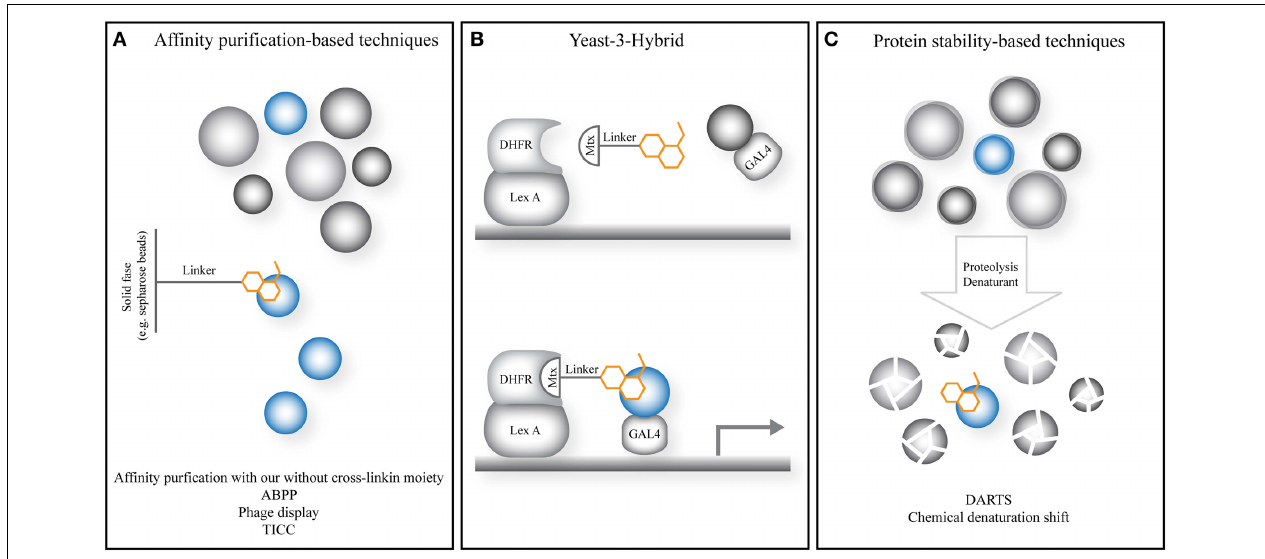
FIGURE 2 | General principle of emerging and novel target identification strategies in plant chemical biology. (A) Strategies relying on the affinity of the small molecule to isolate the target protein from a complex mixture such as a lysate or cellular environment. (B) The yeast-3-hybrid approach uses the activation of a transcriptional response by bringing together a DNA-binding domain and transcriptional activator via a fusion of the small molecule of interest and a known small molecule with high affinity for a known protein target. The latter is fused to the DNA-binding domain. The small molecule